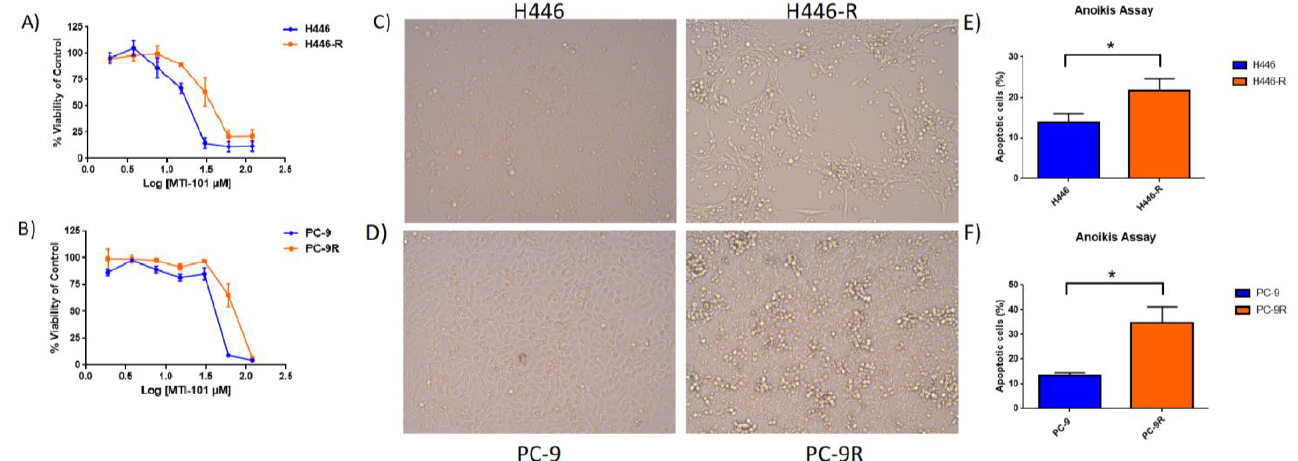
Figure 1. Development of isogenic MTI-101-resistant lung cancer cell lines. ( A ) Twenty-four-hour MTTs were performed with varying drug doses of MTI-101 comparing H446 to its respective resistant cell line. IC50 values were reported as an average n = 3 independent experiments. ( B ) Twenty- four-hour MTTs were performed with varying drug doses of MTI-101 comparing PC-9 to its respec- tive resistant cell line. IC50 values were reported as an average n = 3 independent experiments. ( C , D ) Resistance to MTI-101 induces cell morphological changes to more adherent epithelial-like cells compared to the respective WT on a microscope at 20x magnification. ( E , F ) Anoikis assay comparing WT to respective resistant cell line for apoptotic percentage in low attachment plate. Results reported as n = 3. Error bars represent SEM (significances denoted * for p < 0.05, two-tailed T -test).